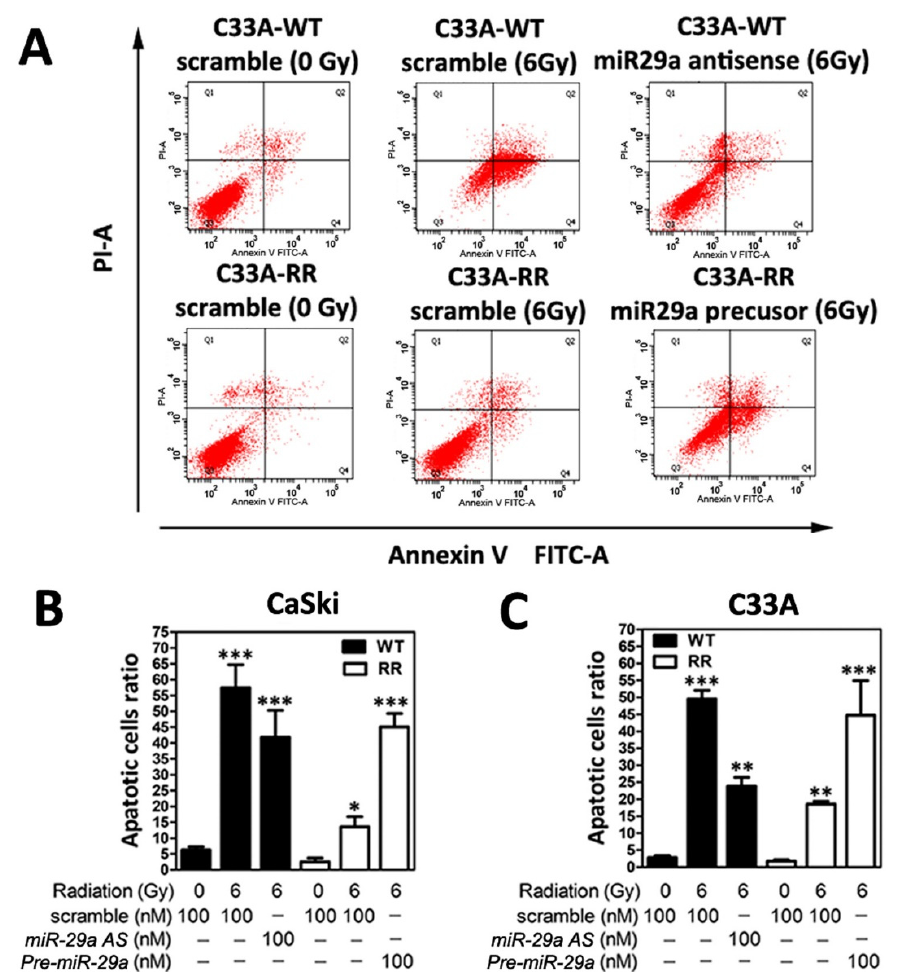
Figure 3. Suppressed apoptosis rate was exhibited in radioresistant CaSki and C33A cells, and overexpression of microRNA-29a triggered the apoptosis in radioresistant cervical cancer cells. ( A ) Representative figure of flow cytometric analysis Annexin-V/PI double staining was executed on WT- or RR-CaSki cells, which were pre-transfected with Scramble NC, miR-29a AS, or Pre-miR29a , and then were subjected to the 6-Gy radiation treatment and the apoptosis rate was estimated, as described in Section 4.6. Summary of apoptotic cells (sum of Annexin-V-positive/PI-negative and Annexin-V-positive/PI-positive cells) over 48 h after 6-Gy radiation treatment. ( B ) CaSki cells or ( C ) C33A cells. Data were obtained from three independent experiments in triplicate and shown as the mean ± SD. * p < 0.05, ** p < 0.01, *** p < 0.001.